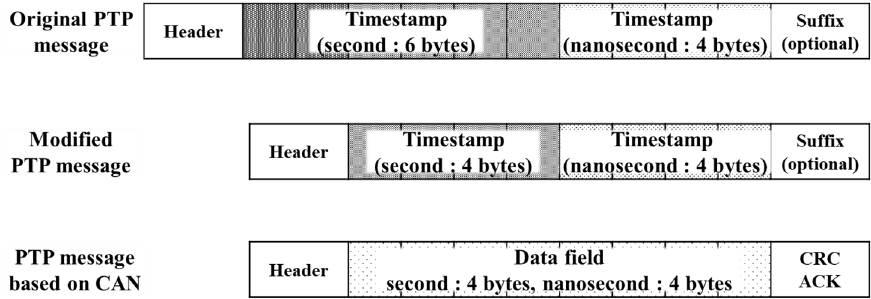
Figure 3. Comparison of the PTP message format in the CAN and Ethernet network.